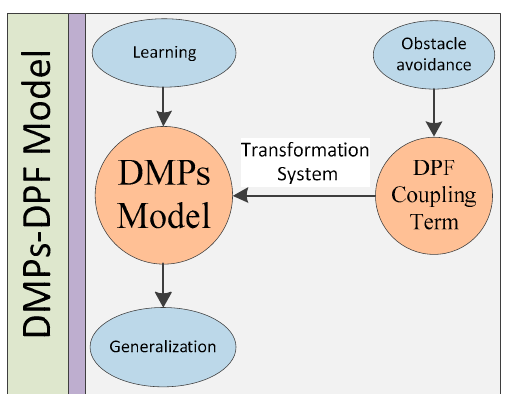
Figure 3. Block diagram of dynamic movement primitives combined with dynamic potential field (DMPs-DPF) approach.